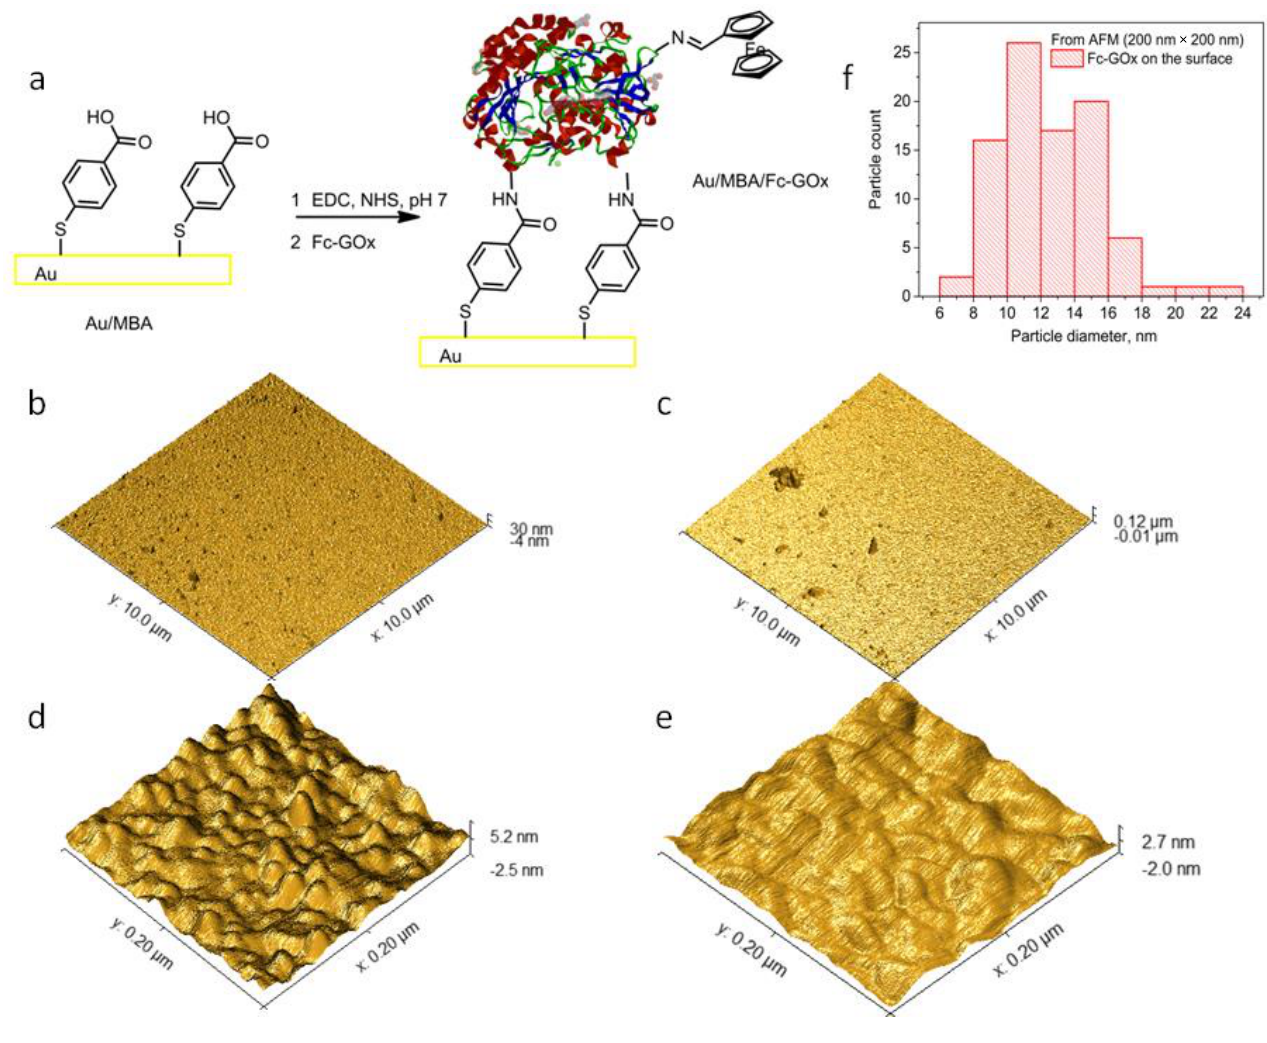
Figure 2. AFM analysis of the modified gold substrates: ( a ) schematic presentation of the self-assembly monolayer of Fc-GOx deposition on Au; ( b ) AFM picture of GOx/MBA/Au at dimensions of 10 × 10 μm; ( c ) AFM picture of Fc-GOx/MBA/Au at dimensions of 10 × 10 μm; ( d ) AFM picture of Fc-GOx/MBA/Au at dimensions of 200 × 200 nm; ( e ) AFM picture of the surface of bare Au at dimensions of 200 × 200 nm; ( f ) grain diameters distributions on the Fc-GOx/MBA/Au surface at dimensions of 200 × 200 nm.